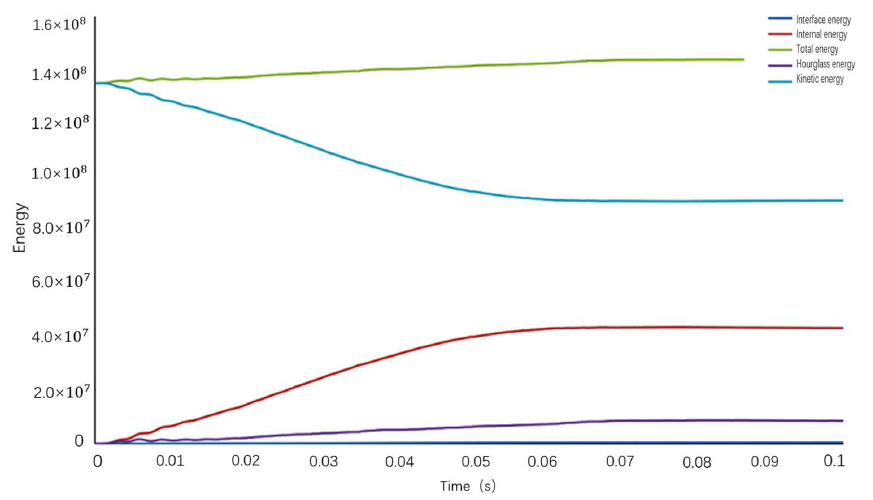
Figure 10. Energy curve of vehicle-side crash.